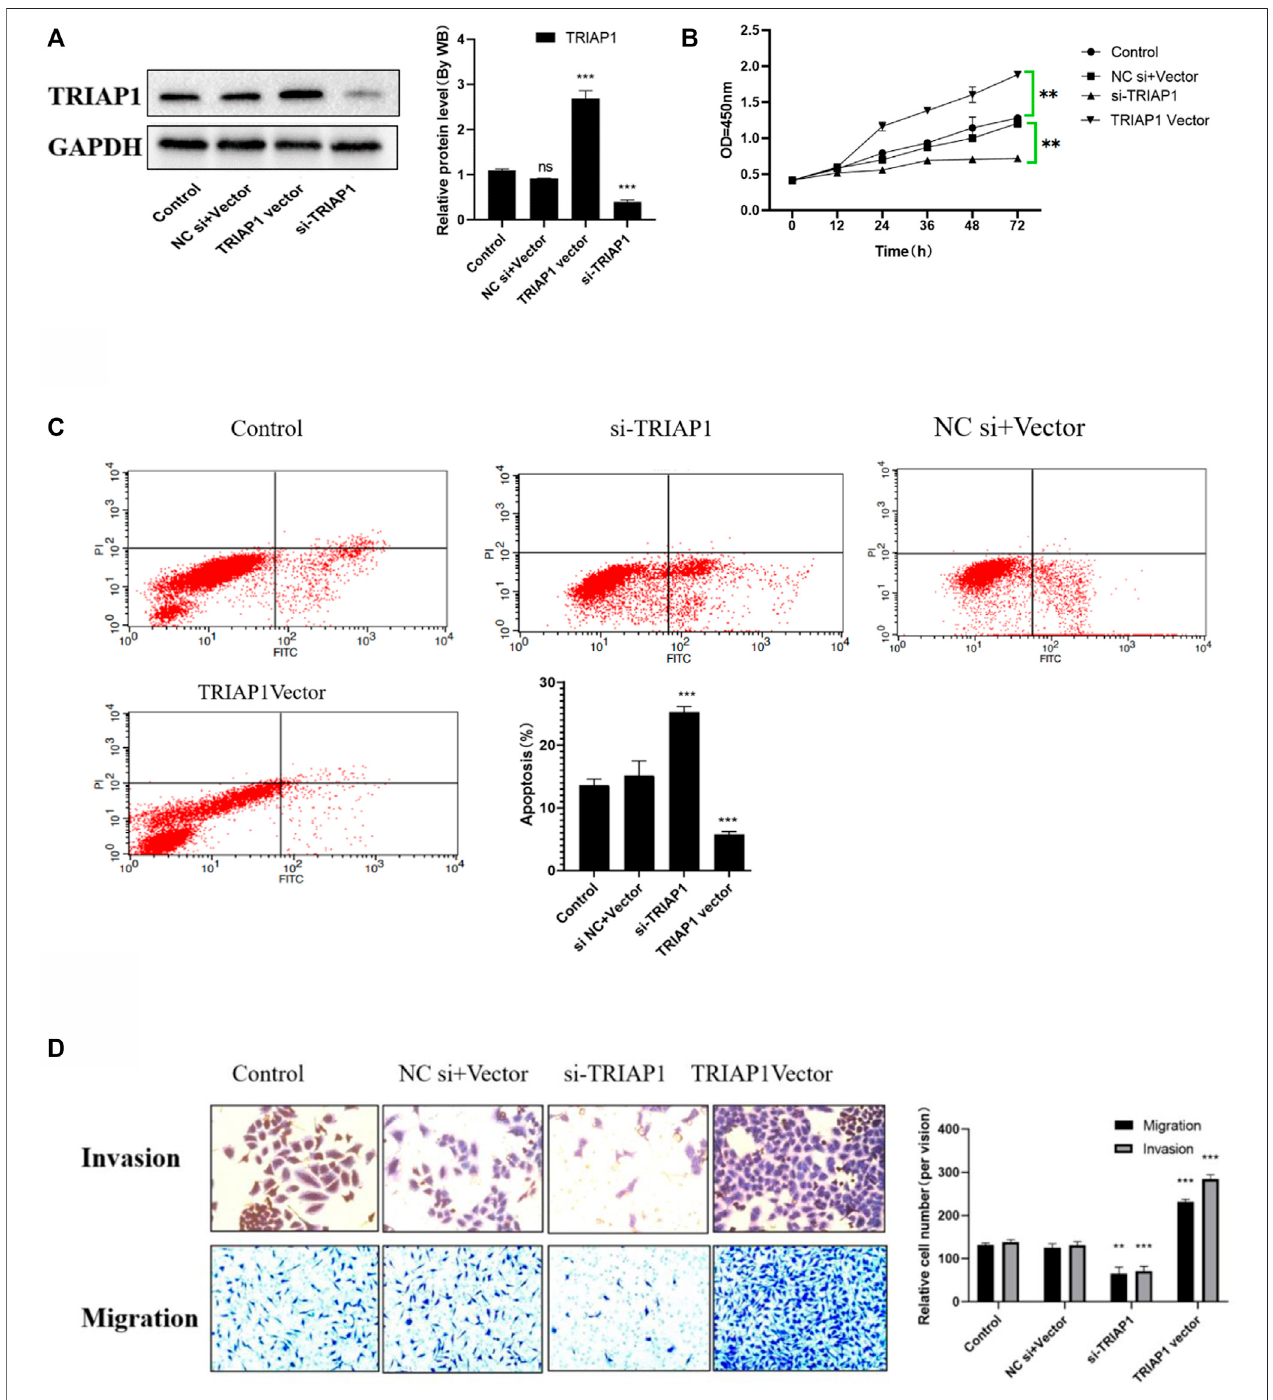
FIGURE3| TRIAP1promotestheactivityofNCI-N87cells invitro . (A) TheexpressionlevelofTRIAP1wasdetectedbyWestern-blotafterdifferenttransfections, (B) Proliferation activity of NCI-N87 cells after different transfection, (C) Apoptosis of NCI-N87 cells after different transfection, (D) Invasion and migration of NCI-N87 cells after different transfections was detected by Transwell, (original picture X100), Compared with the control group,* p < 0.05,** p < 0.01,*** p < 0.001.